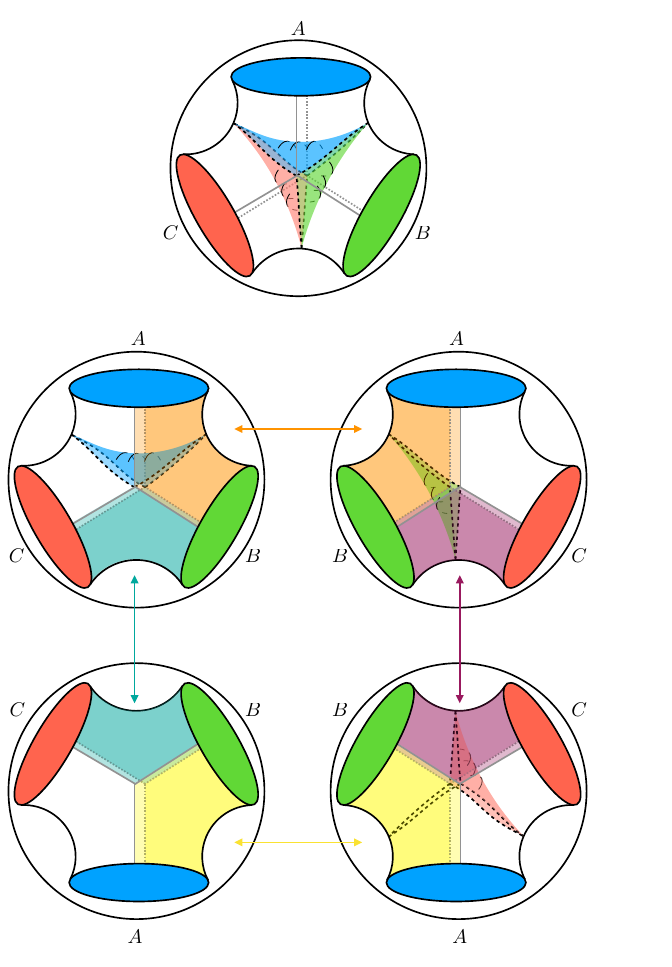
Figure 9 . Formation of M 0 from four copies of a tripartite entanglement wedge in three (spatial) dimensions. Copies of the wedge are joined along shaded parts of m ( ABC ) that have the same